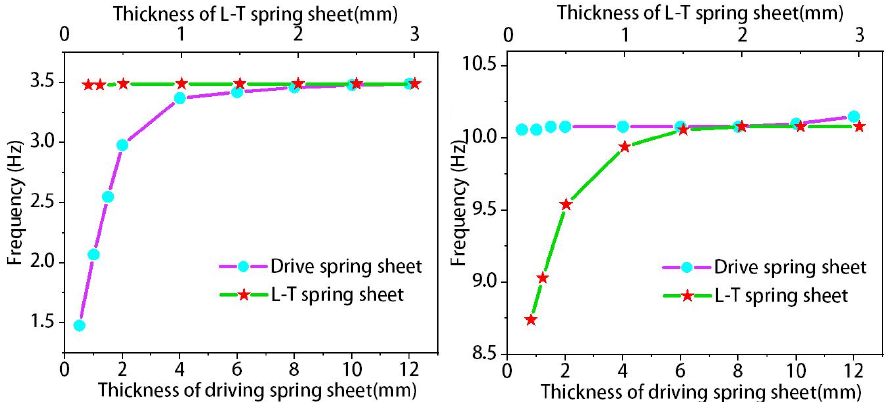
Figure 7. Effect of leaf springs geometry thickness on the vibration frequency of similar models.